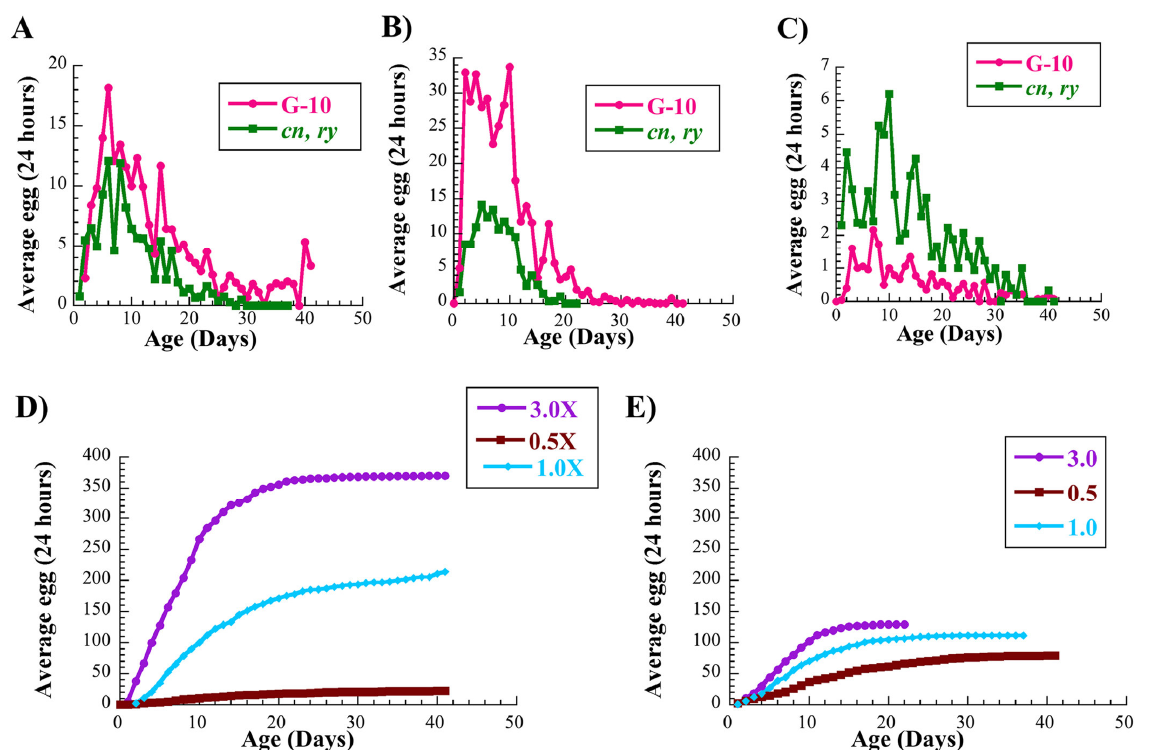
FIGURE 1. Overexpression of SP increases the fecundity of females on 1.0X and 3.0X food levels. Daily egg production of G-10 flies overexpressing SP (magenta) and control cn, ry flies (green) on 1.0X (A), 3.0X (B), and 0.5X food (C). (D and E) Cumulative egg production of G-10 female flies (D) and genetic controls, cn,ry (E) on 3.0X (purple), 1.0X (blue), and 0.5X (brown) food levels presented in A, B, and C. G-10 flies have higher average and cumulative lifelong egg production on 1.0X and 3.0X food, but laid fewer eggs on 0.5X food. There were 20 females in each